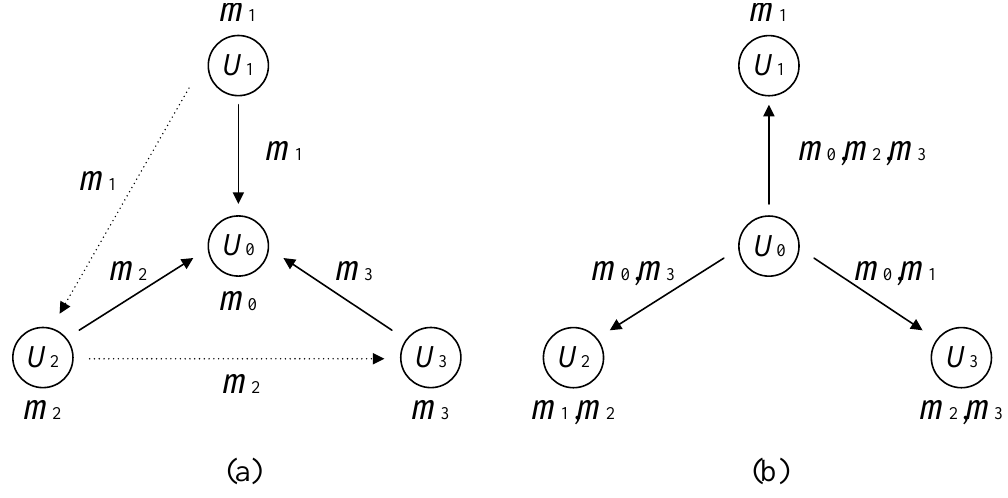
Figure 2. One example of the multiway relay channel with full data exchange. ( a ) The users transmits to the relay in turn, and the messages may be overheard by other users; ( b ) The relay broadcasts to all the